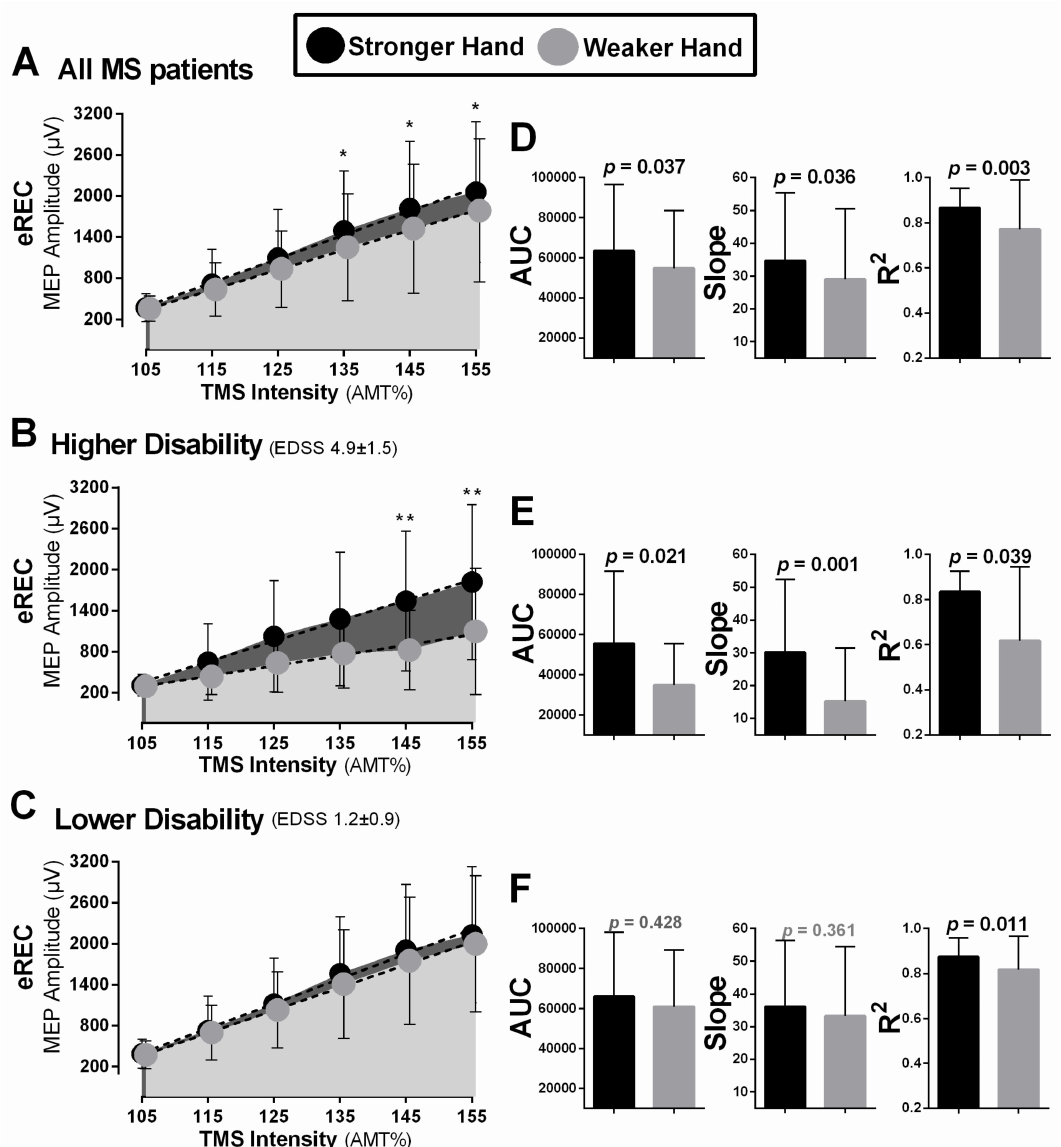
Figure 8. Differences in the Excitatory Recruitment Curve (eREC). ( A ) With all participants in the same analysis, when compared to the hemisphere corresponding to the stronger hand, the hemisphere corresponding to the weaker hand demonstrated significantly lower motor evoked potential (MEP) amplitudes ( µ V) at the transcranial magnetic stimulation (TMS) intensities of 135–155% of the AMT (*, p < 0.05). When groups were stratified based on levels of disability, ( B ) only the group with higher level of disability (EDSS) ≥ 3) demonstrated lower MEP amplitudes in the weaker hand (**, p < 0.01) at the intensities of 145 and 155% of the active motor threshold (AMT), whereas ( C ) no statistically significant difference between hemispheres was noted across MEP amplitudes (105–155% of AMT) in the group with lower level of disability (EDSS < 3). ( D ) With all participants in the same analysis, the eREC parameters of overall excitation (AUC, area under the curve), gain (slope), and accuracy (R 2 ) were significantly lower in the weaker compared to the stronger hand. When separating participants into groups based on disability levels, ( E ) the group with a higher level of disability (EDSS ≥ 3) demonstrated significantly lower excitatory recruitment curve gain (slope), overall excitation (AUC), and accuracy (R 2 ) in the hemisphere corresponding to the weaker hand when compared to the stronger hand. ( F ) In the group with a lower level of disability, overall excitation (AUC) and gain (slope) did not significantly differ between hemispheres, whereas accuracy (R 2 ) was significantly lower in the hemisphere corresponding to the weaker hand. Error bars represent one standard deviation ( ± SD) of the mean. EDSS, expanded disability status scale (MS severity; 0 = no disability, to 10 = death due to